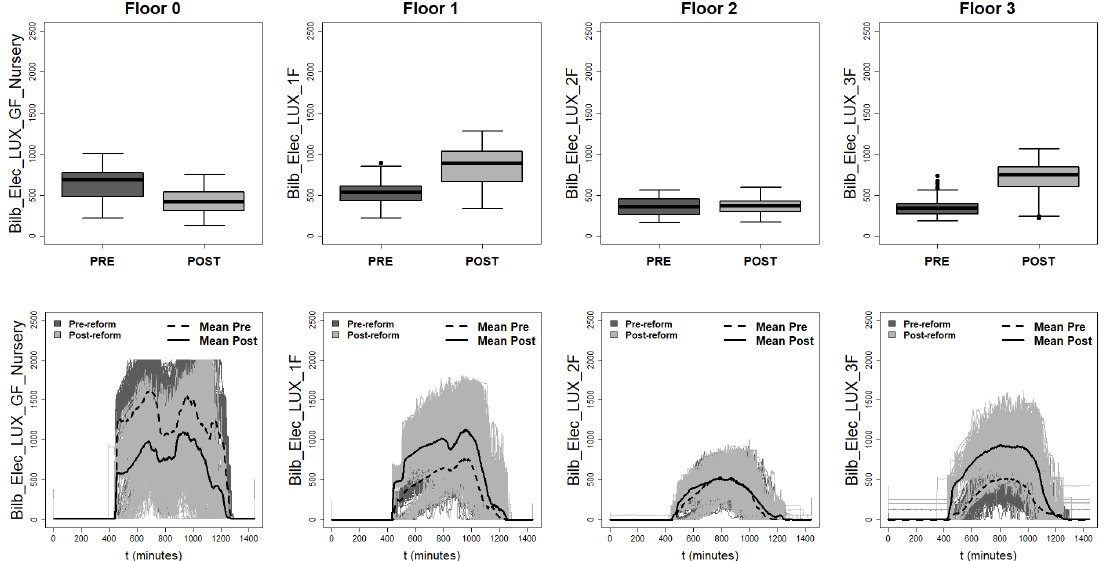
Figure 6. Analysis of the illuminance on each floor measured in lx. In the first row, the vectorial results (in form of box plots) are presented. In the second row, instead, the functional data represented with the respective mean functions. The data are divided into winter days before and after the